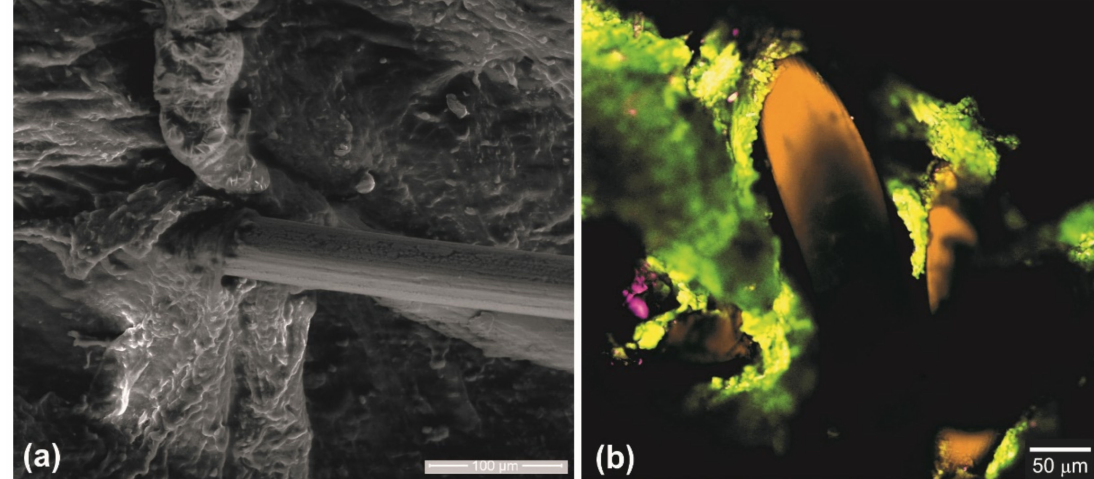
Figure 14. Knitted mesh from 60 µ m NiTi wire integrated into the rat tissues of the anterior abdominal wall: ( a ) SEM; ( b ) confocal